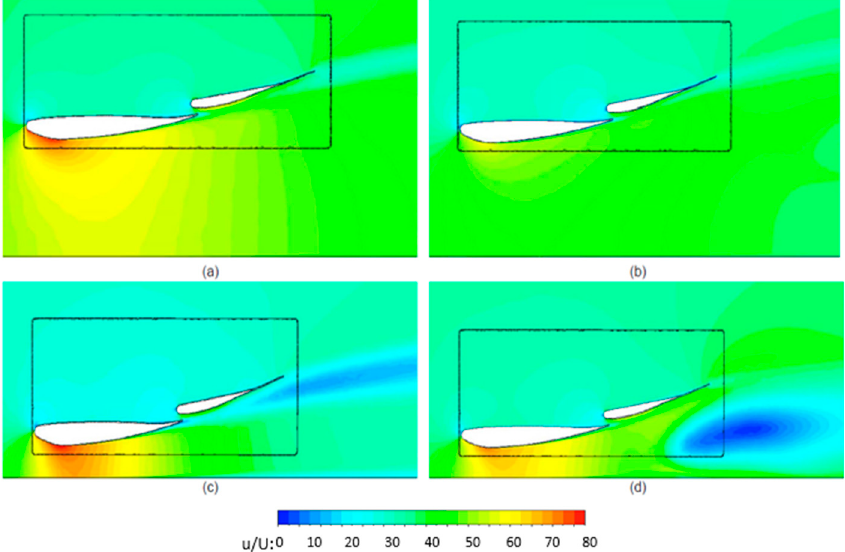
Figure 8. Velocity contours at wing centre and wing tip at different heights ( a ) h/c = 0.395, centre; ( b ) h/c = 0.395, tip; ( c ) h/c = 0.105, centre; ( d ) h/c = 0.105, tip.